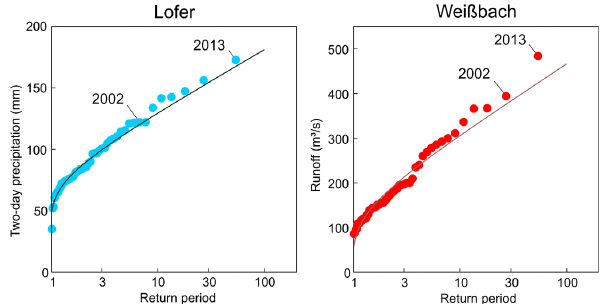
Fig. 7. (left) Statistical analysis of annual maximum precipitation (48h totals, 07:00–07:00) for the Lofer rain gauge near Weißbach. (right) Statistical analysis of annual maximum runoff for Weißbach (567km 2 ). Lines show fitted Gumbel distributions. Lofer data 1961–2013. Weißbach data 1959–2013. The 1954 and 1899 pre- cipitation depths of 233 and 329mm, respectively, are not included in the